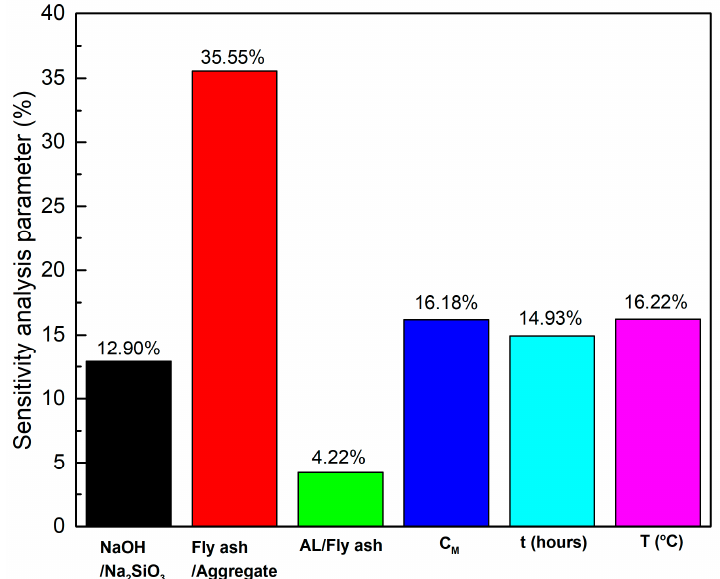
Figure 10. Sensitivity analysis parameters for the estimated compressive strength of FAGP concrete.